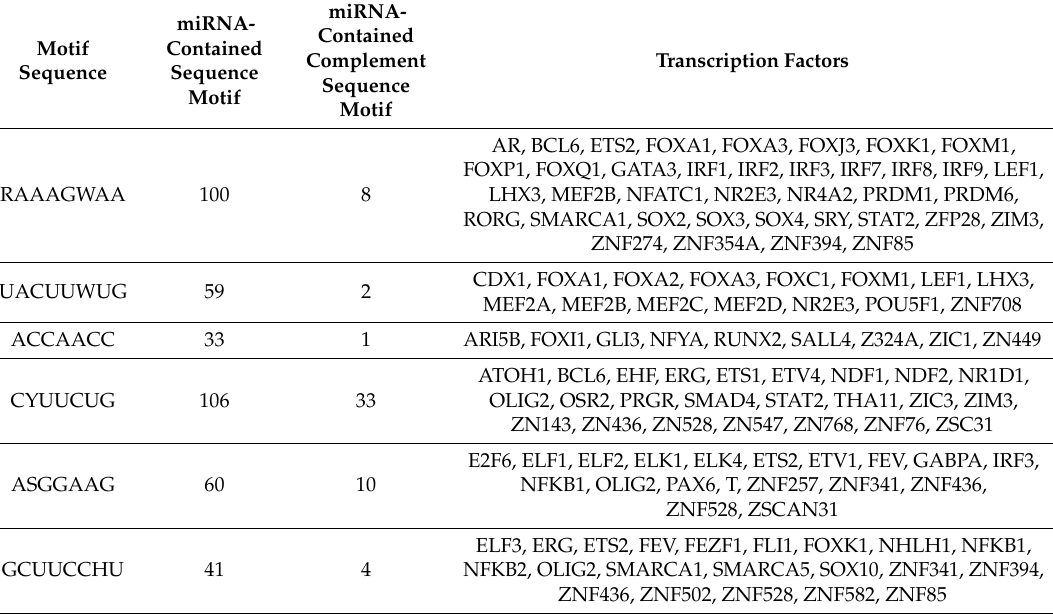
Table 1. MicroRNA (miRNA) conserved